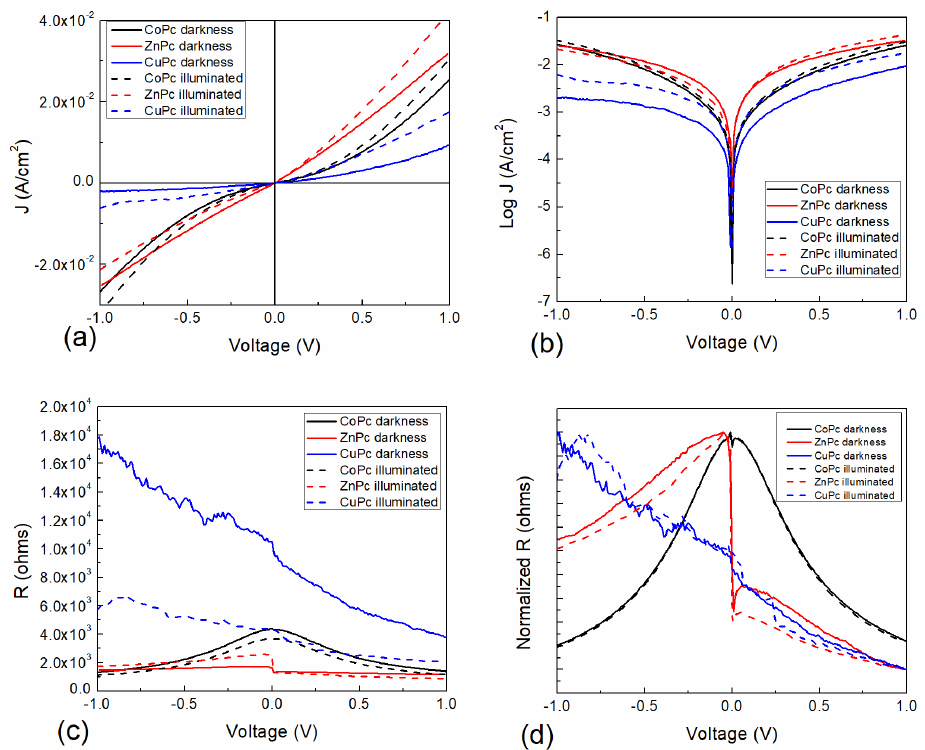
Figure 7. Doped MPcs (M = Co, Zn, Cu) for darkness and illuminated conditions ( a ) J-V curve, ( b ) semi-Log J-V curve, ( c ) voltage-dependent resistance and ( d ) voltage-dependent normalized re- sistance. Table 2. Electrical properties of doped MPcs (M = Co, Zn, Cu) for darkness and illuminated condi- tions.